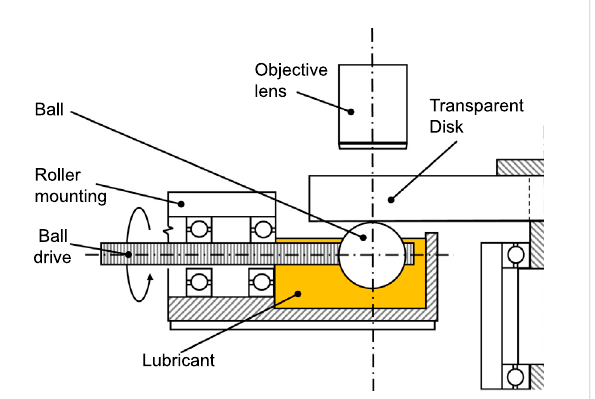
FIGURE 2 Schematicrepresentation ofthemechanicallayout